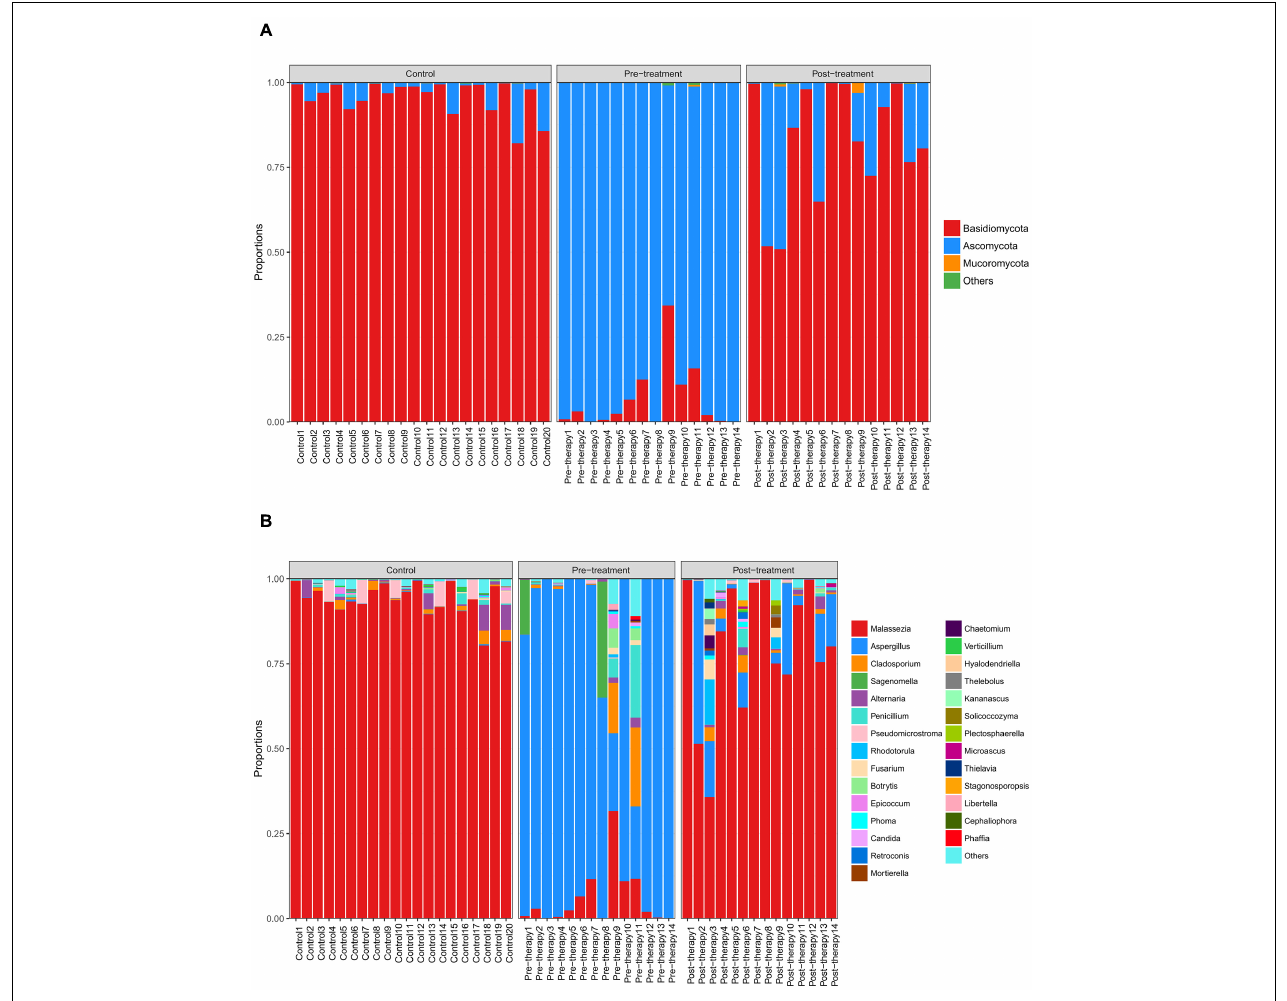
FIGURE 3 | Distribution of predominant fungi in three groups at the phylum and genus levels. Different colors indicate different phylum and genus names of fungus, and the colored blocks on the right are sorted in order of abundance from high to low. (A) The distribution of predominant fungi at the phylum level. Basidiomycota is dominant in the control and post-treatment groups, while Ascomycota is dominant in the pre-treatment group. (B) The distribution of predominant fungi at the genus level. Malassezia is dominant in the control and post-treatment groups, while Aspergillus dominates in the pre-treatment group.